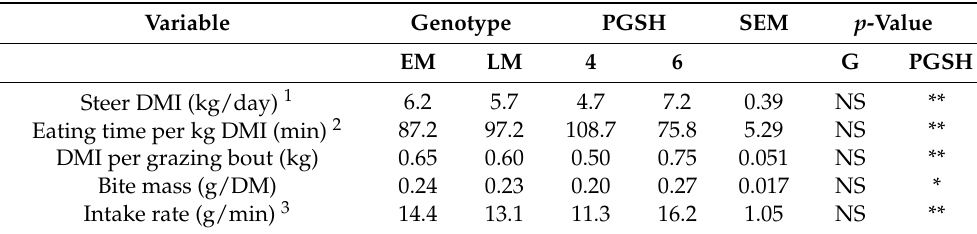
Table 3. Effect of genotype (G-early- (EM) or late-maturing (LM)) and post-grazing sward height (PGSH-4 or 6 cm) on herbage dry matter intake (DMI), bite mass and intake rate during a 48-h